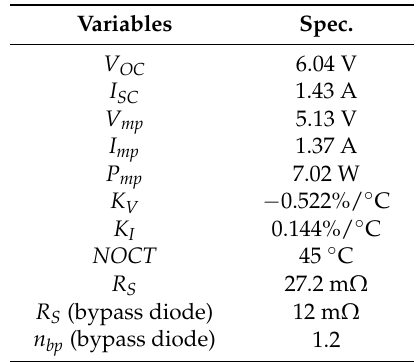
Table 1. Parameters of the experimental modules.